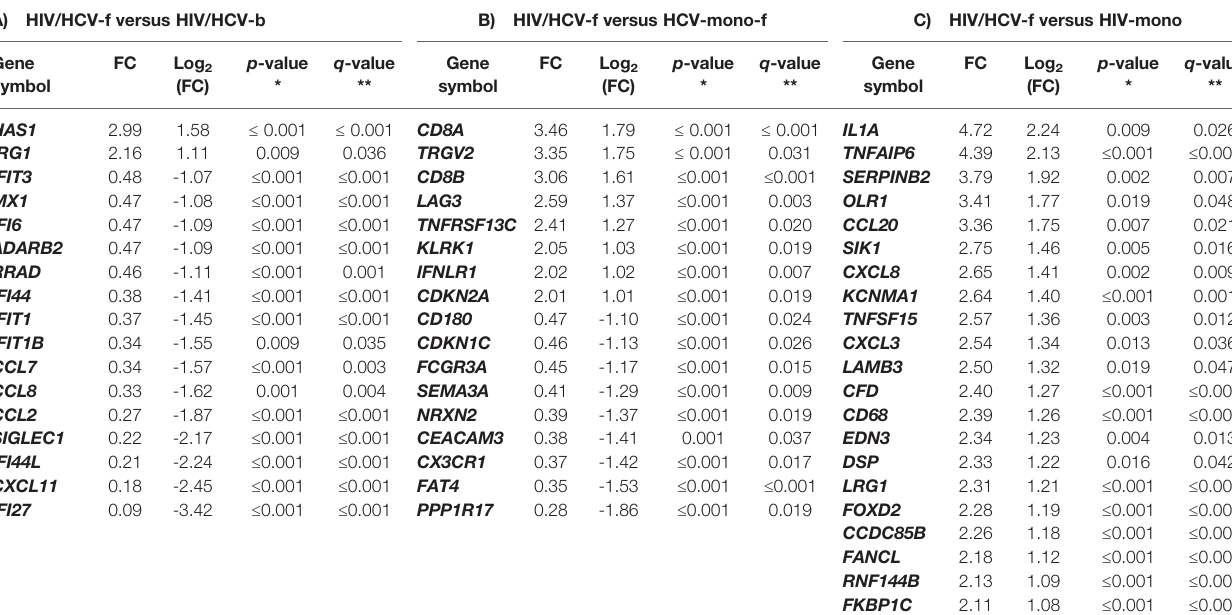
TABLE 3 | Summary of signi fi cant differentially expressed genes (absolute fold-change ≥ 2; FDR ≤ 0.05) in peripheral blood mononuclear cells between: A) HIV/HCV- coinfected at week 36 after SVR (HIV/HCV-f) versus HIV/HCV-coinfected at baseline (HIV/HCV-b). B) HIV/HCV-coinfected at week 36 after SVR (HIV/HCV-f) versus HCV- monoinfected at week 36 after SVR (HCV-mono-f); C) HIV/HCV-coinfected at week 36 after SVR (HIV/HCV-f) and HIV-monoinfected (HIV-mono). A) HIV/HCV-f versus